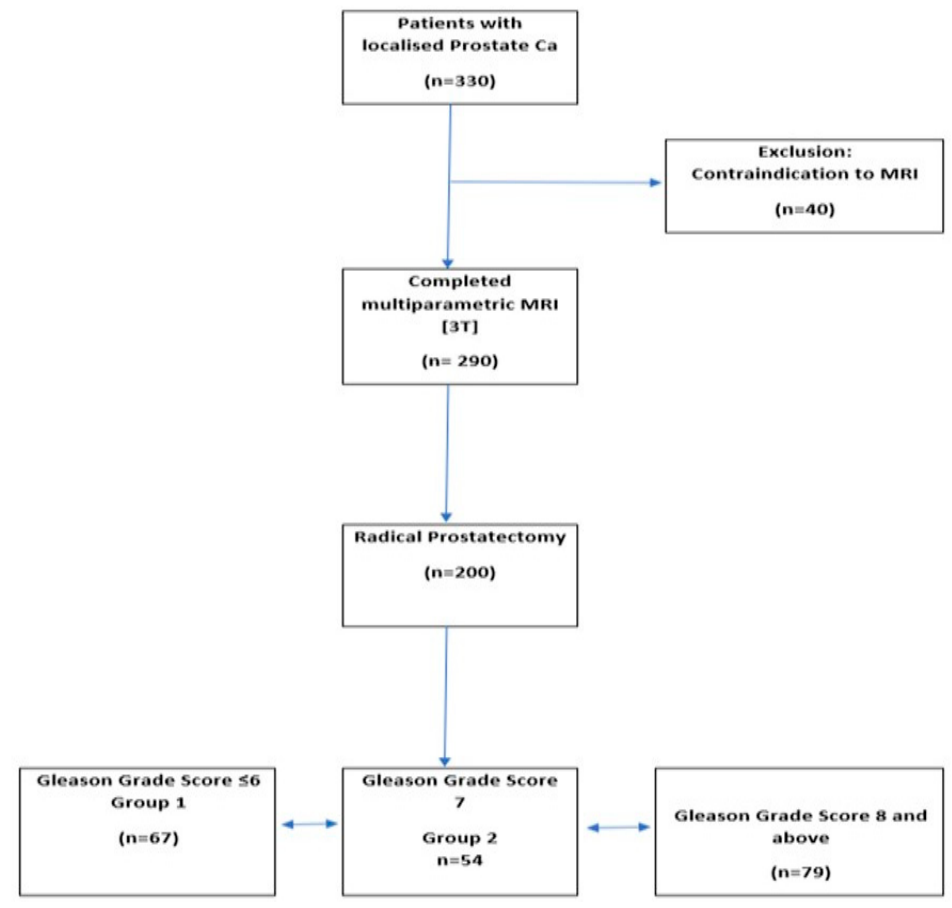
Figure 2. Study flowchat.